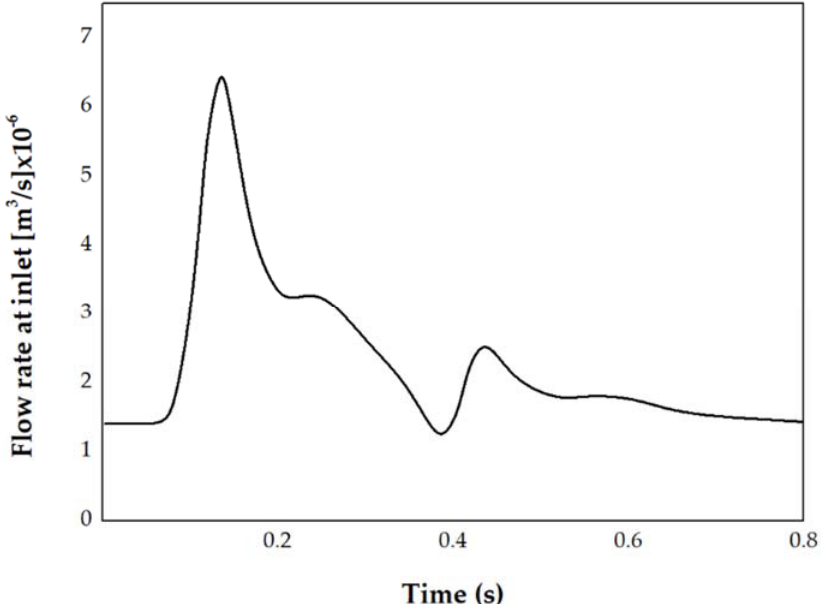
Figure 1. One cardiac cycle of flow rate according to time [18]. Using the flow rate and patient-specific inlet area, the velocity profiles for each patient were calculated for inlet boundary condi ‐ tions.